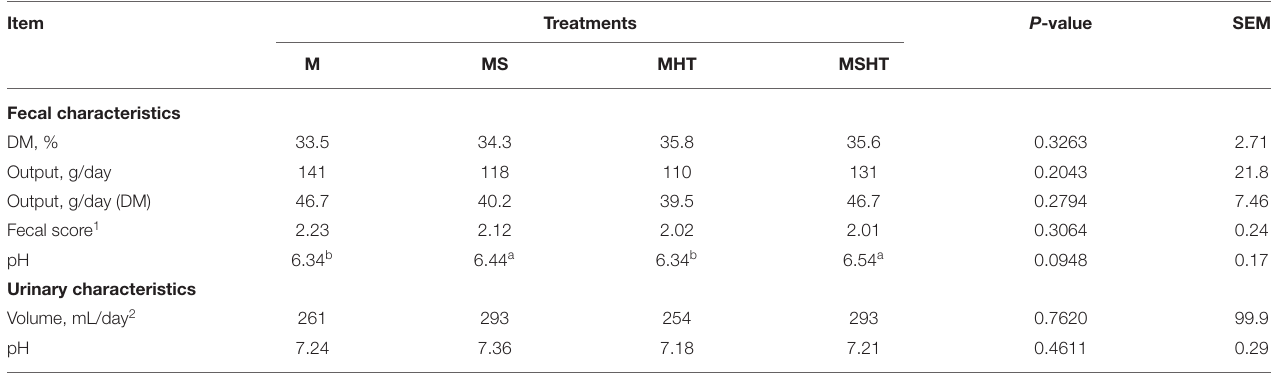
TABLE 6 | Fecal and urinary characteristics of dogs fed the experimental diets. Item Treatments P -value SEM M MS MHT MSHT